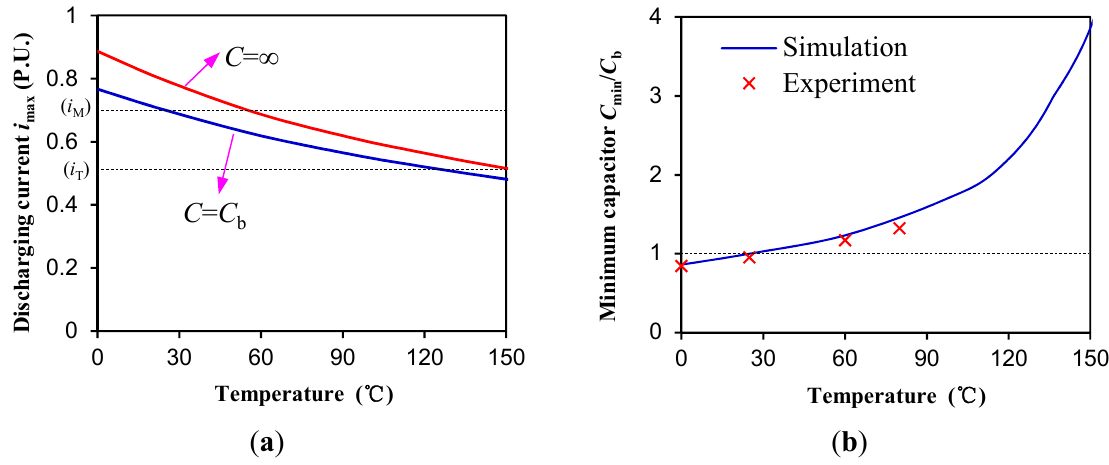
Figure 15. Electromagnetic characteristics variation with temperature. ( a ) Maximum discharge current; ( b ) Minimum capacitor enables the work of the